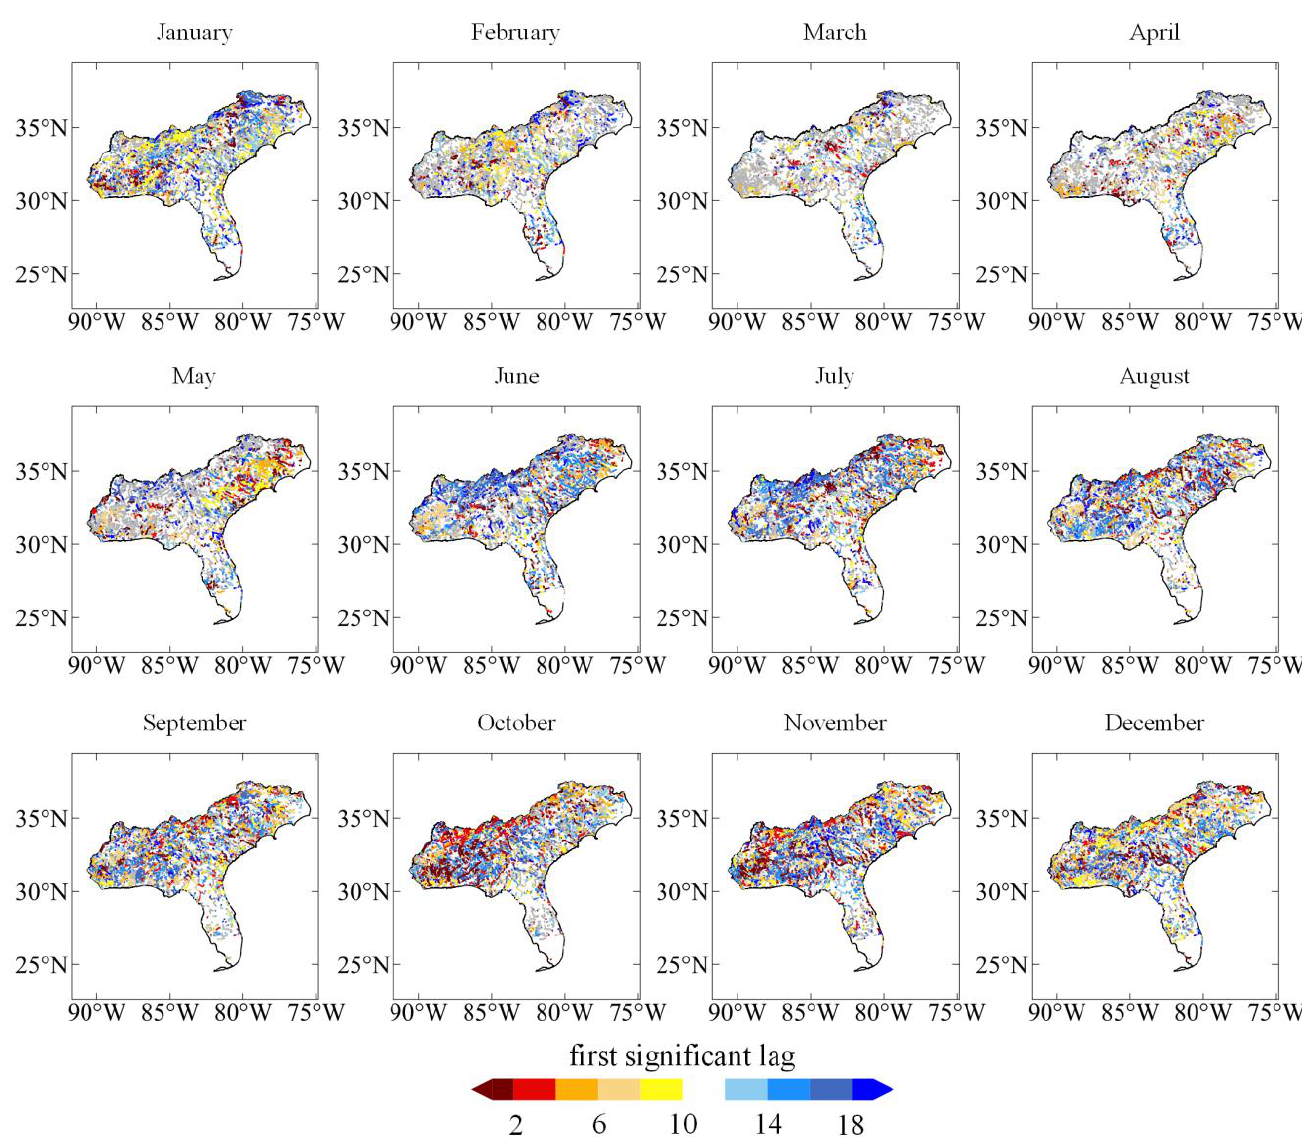
Figure 8. First significant lag in monthly PACF distributions.